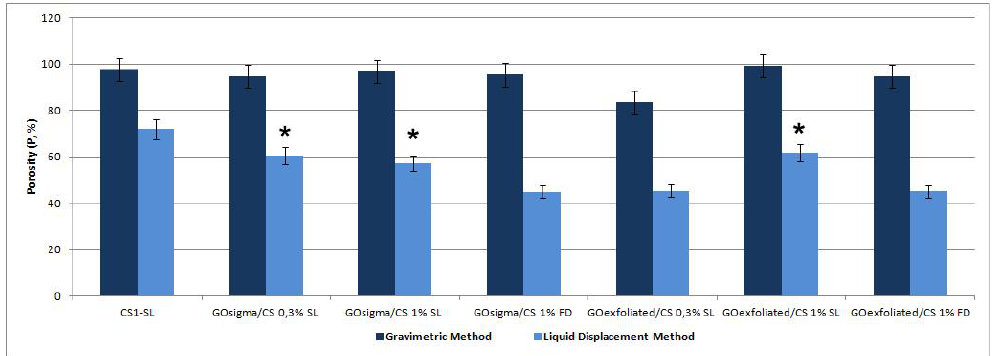
Figure 6. Porosity (%) of all the prepared scaffolds. The symbol (*) indicates samples with the best interconnected porosity.